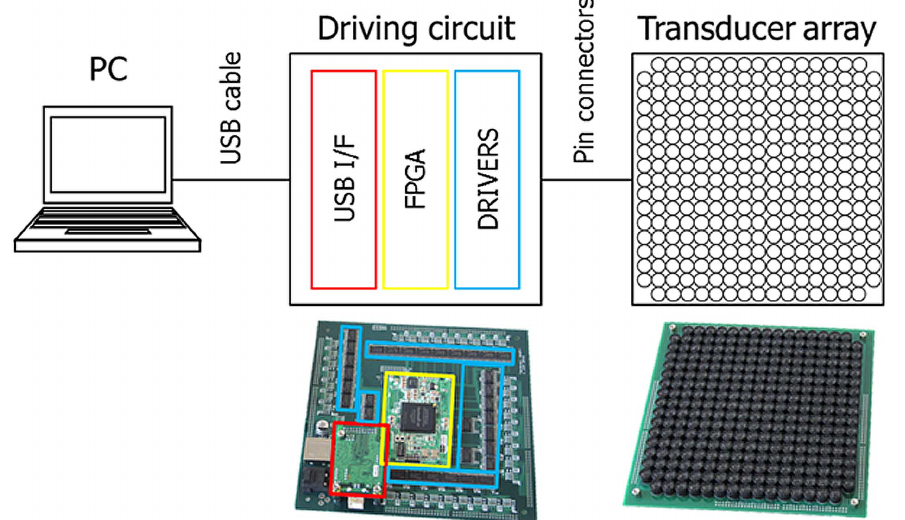
Figure 2. Phased array modules. (Left) The phased array modules are operated by a computer via USB. (Middle) Each driving circuit board consists of three components; USB I/F, FPGA, and Driver ICs. (Right) Each phased array module has 285 ultrasonic transducers.